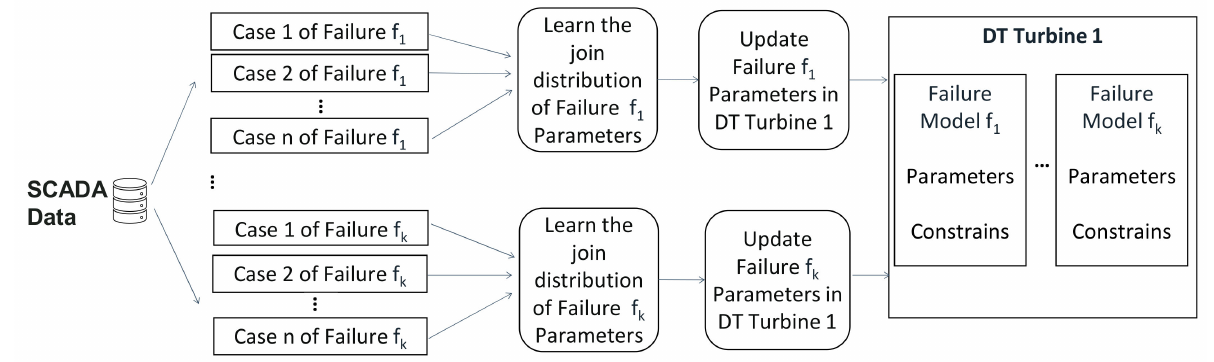
Figure 5. Observation process for